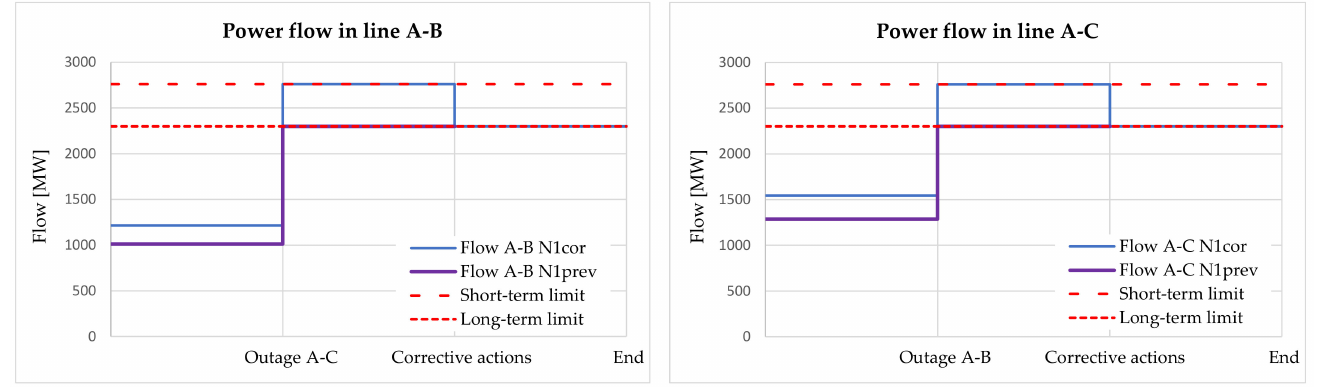
Figure 7. Power flows in line A-B and A-C in N1prev and N1cor